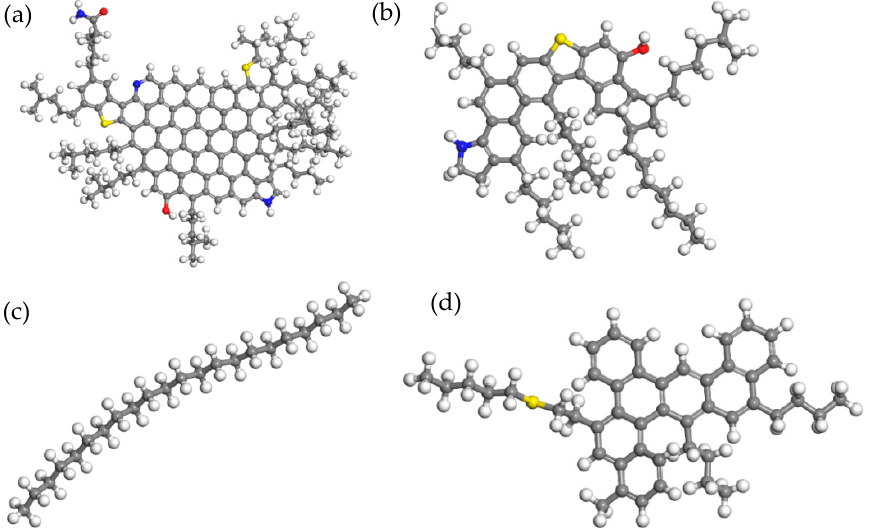
Figure 1. Three-dimensional structure diagram of the four components of asphalt: ( a ) asphaltenes; ( b ) resins; ( c ) saturates; and ( d ) aromatics. Note: white atoms = H, black atoms = C, yellow atoms = S, blue atoms = N, red atoms = O.